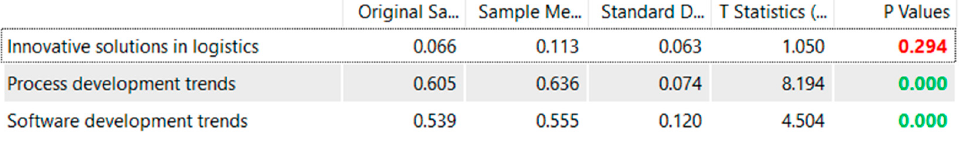
Figure 3. Quality criteria: R2 of the model.